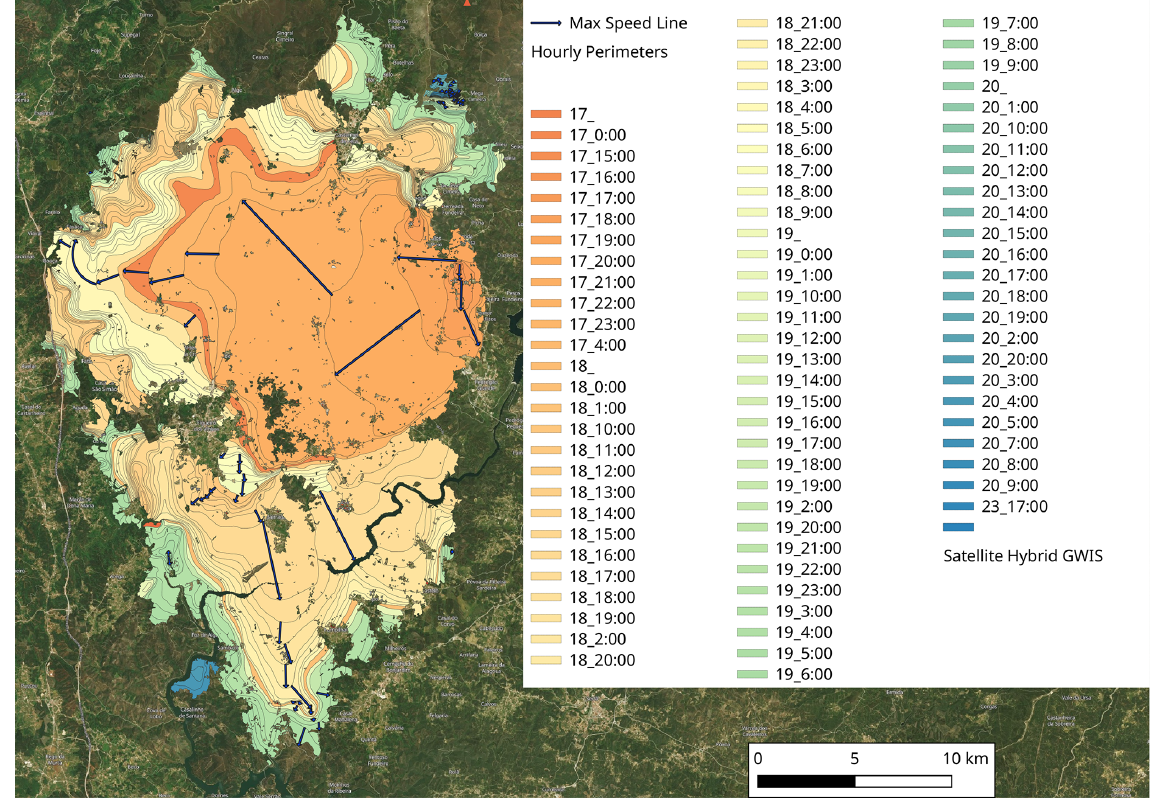
Figure 6. Time sequence of the wildfire which took place in Pedrógão Grande (Comissão Técnica Independente, 2017), Portugal, on 17 June 2017. The maximum speed line between time steps is shown with a black arrow. Background image © MapTiler (https: //maptiler.com/copyright, last access: 15 March 2021). GWIS: Global Wildfire Information